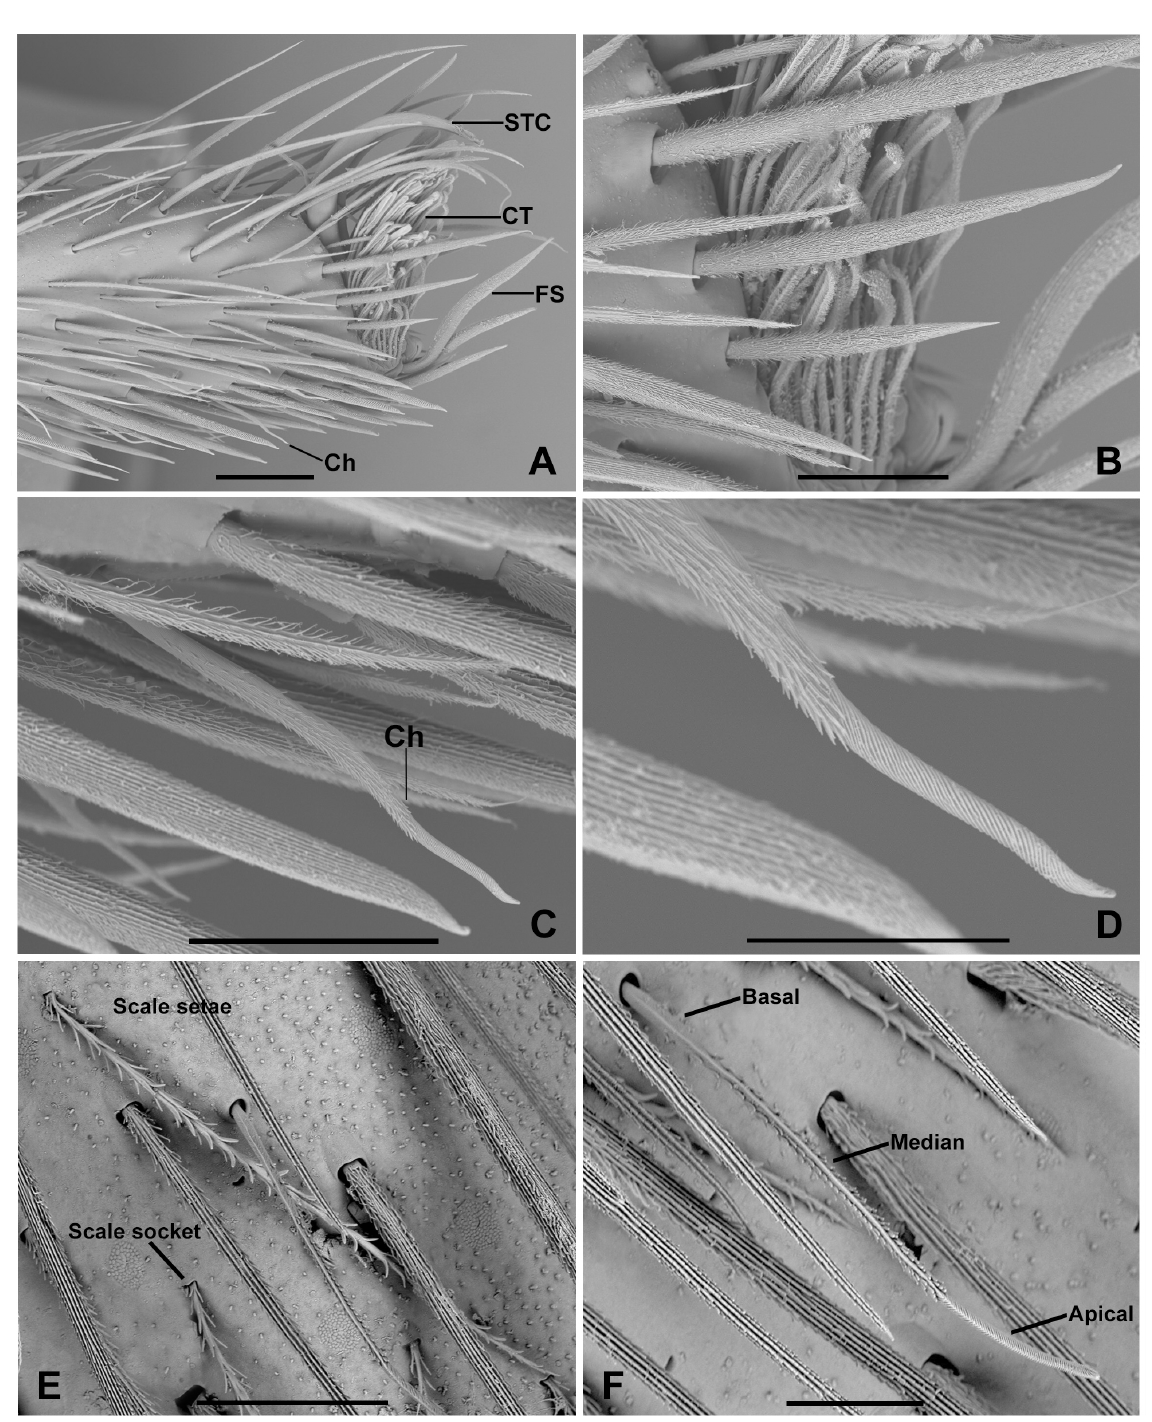
Fig. 7. SEM micrographs of Ammonius pupulus Thorell, 1899, ♀ (RMCA 169416), tarsus IV. A . Lateral view. B . Detail of macrosetae, lateral view. C . Chemosensory setae. D . Apical detail of the chemosensory setae. E . Scale setae. F . Chemosensory setae. Abbreviations: Ch = chemosensory setae; CT = claw tufts; FS = frictional setae; STC = superior tarsal claws. Scale bars: A = 100 µm; B–C = 50 µm; D = 20 µm; E = 50 µm; F = 30